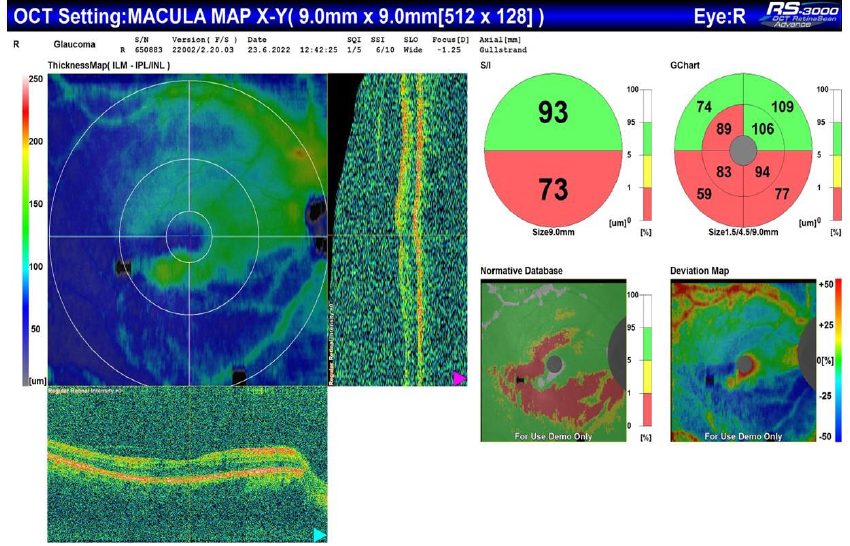
Figure 2. OCT of the same patient with corresponding arquate defect in the inferior half of the visual field.